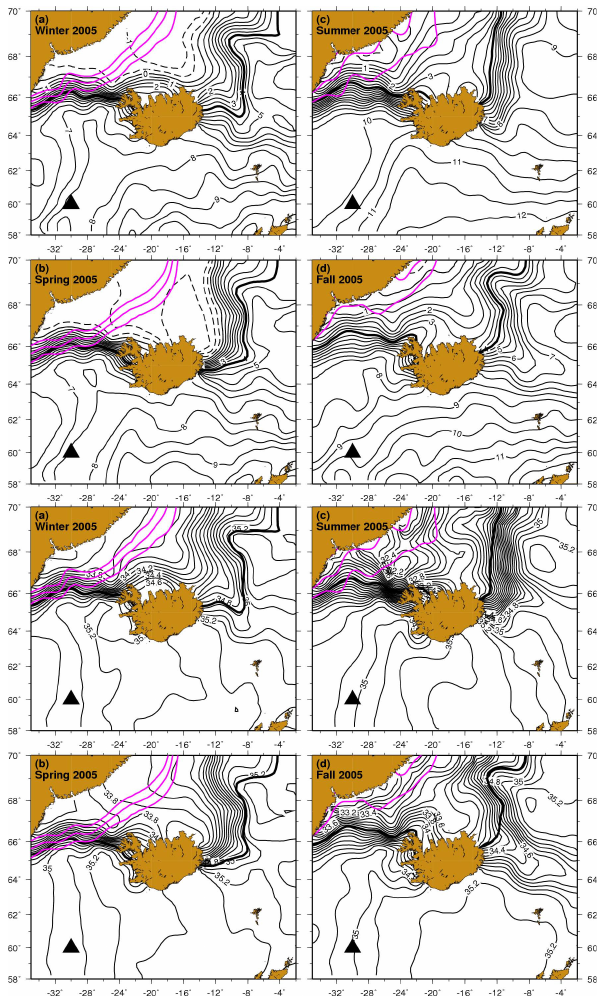
Fig. 2. Seasonal maps of GPOMZ SST (left panel, a through d) and SSS (right panel, a through d) for 2005. The 3D ice concentra- tion contours (20%, 40%, and 60% purple contours) derived from monthly NOAA/ESRL/PSD optimally interpolated data (OI) are su- perposed. The ECO1D-2.0 site is shown by the black triangle and the thick black lines indicate the Arctic